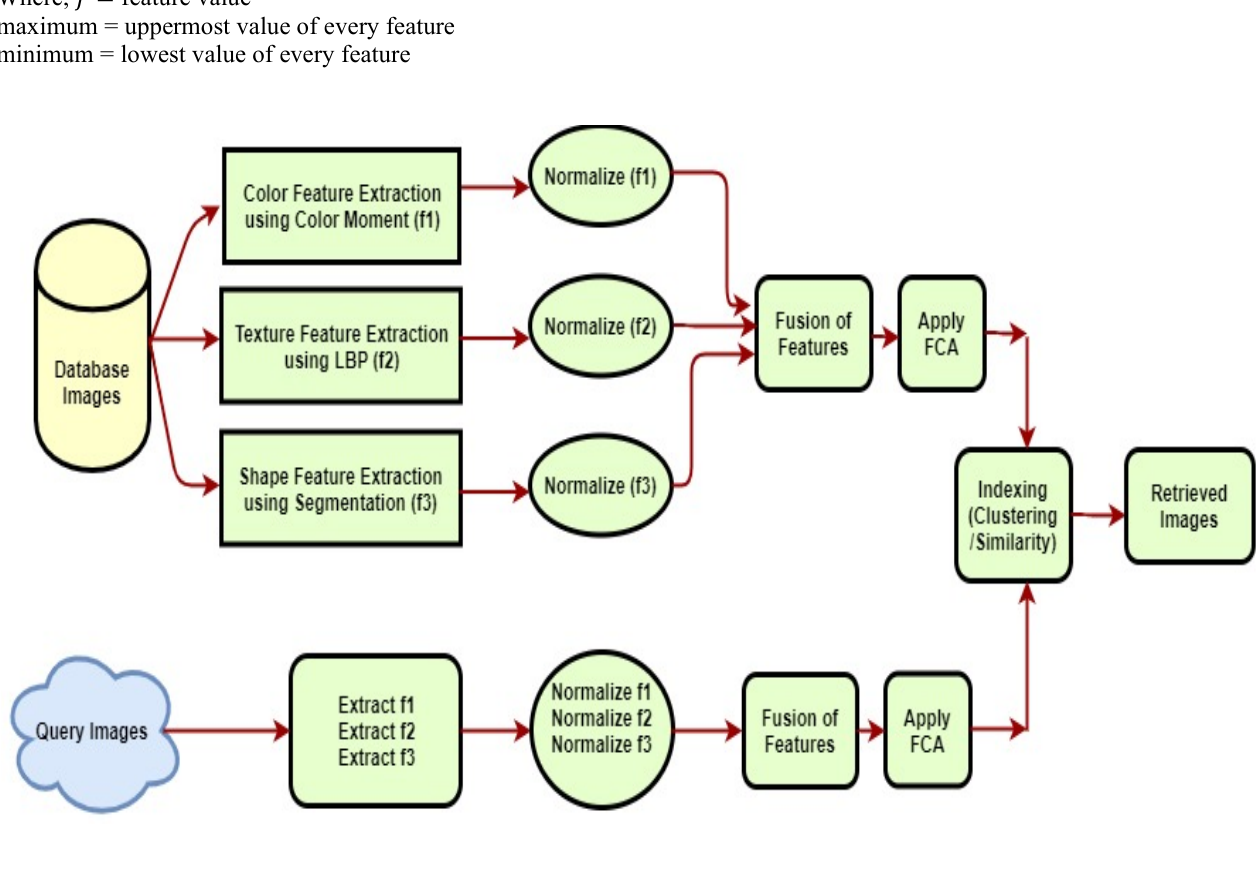
Figure 4. Proposed